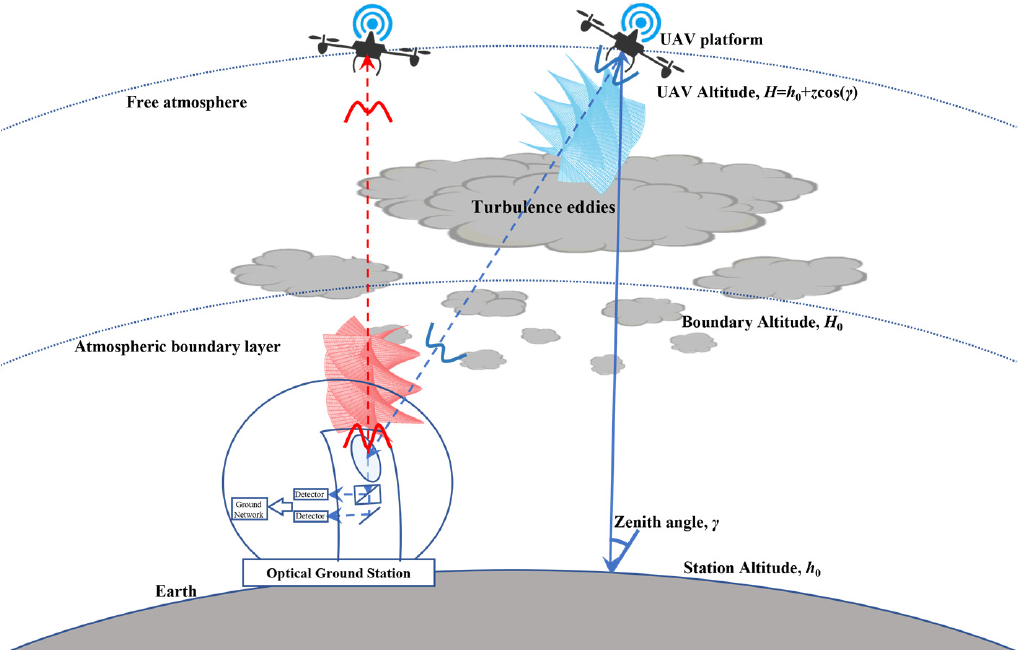
Figure 1. Concept of air–ground OAM communication system in the atmosphere. The air–ground OAM communication system consists of uplink and downlink channels, and information is encoded into an OAM state carried by a vector vortex beam at an optical ground station or a UAV platform. The data-carrying vector vortex beam propagates through a complex atmosphere channel composed of two parts; the free atmosphere and the atmospheric boundary layer. At the receiver, the x and y polarization direction receivers are separately and independently employed to measure the opposite OAM quantum number, and identify them as the same positive OAM mode.